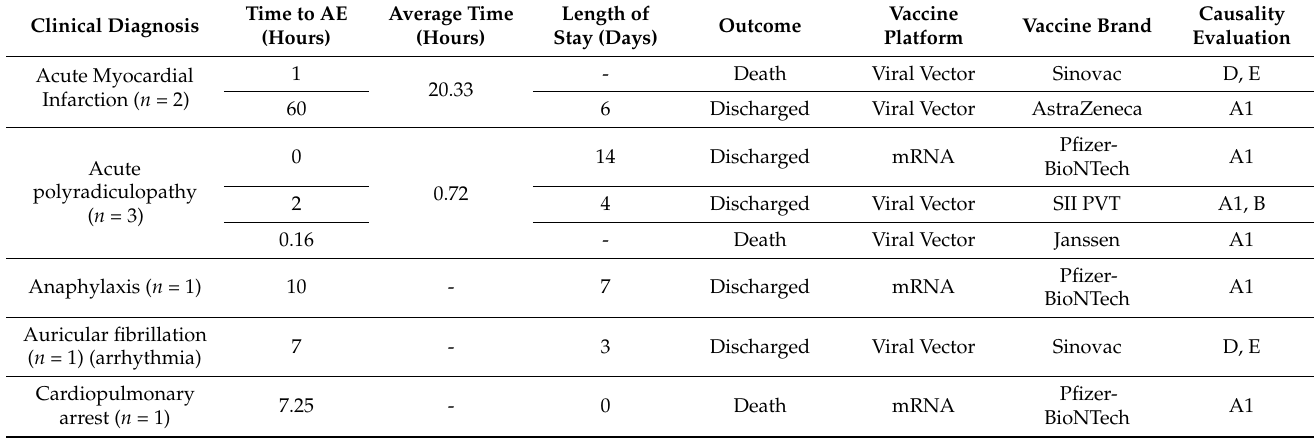
Table 3. A1: adverse event related to the vaccine, A2: adverse event related to a vaccine quality defect, A3: adverse event related to an operative or technical error, B: undetermined, C: causal association inconsistent with vaccination, D: causal association due to inherent characteristic of the vaccinated individual, E: